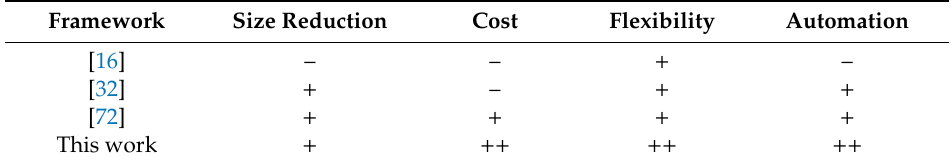
Table 6. Comparison of database-inspired design